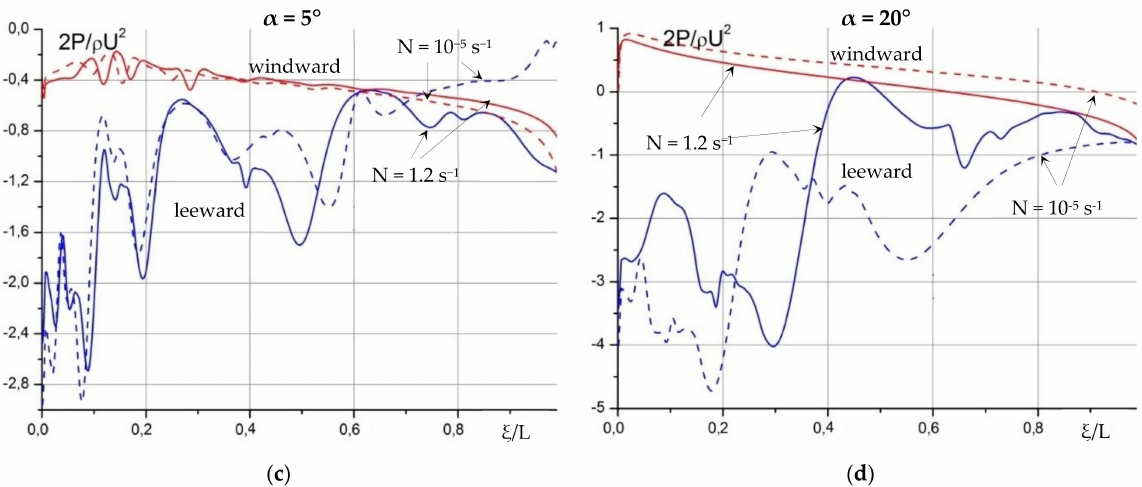
Figure 17. Instantaneous pressure distributions on the windward and leeward sides of a tilted plate in strongly strat- ified ( N = 1.2 s − 1 , solid curves ) and potentially homogeneous ( N = 10 − 5 s − 1 , dotted curves ) fluids, L = 10 cm, U = 100 cm/s, α = 0, 1.0, 5.0, 20 ◦ ( a – d